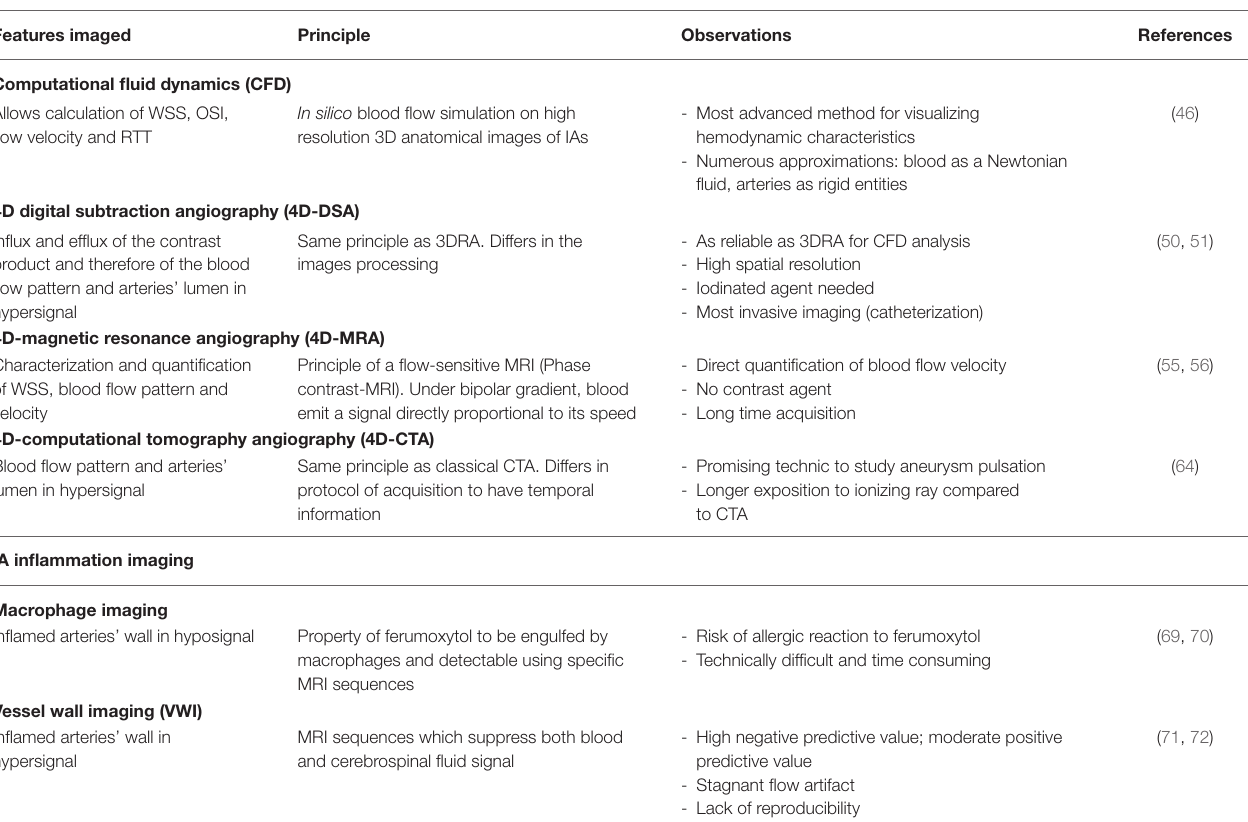
TABLE 2 | IA hemodynamics and inflammation imaging